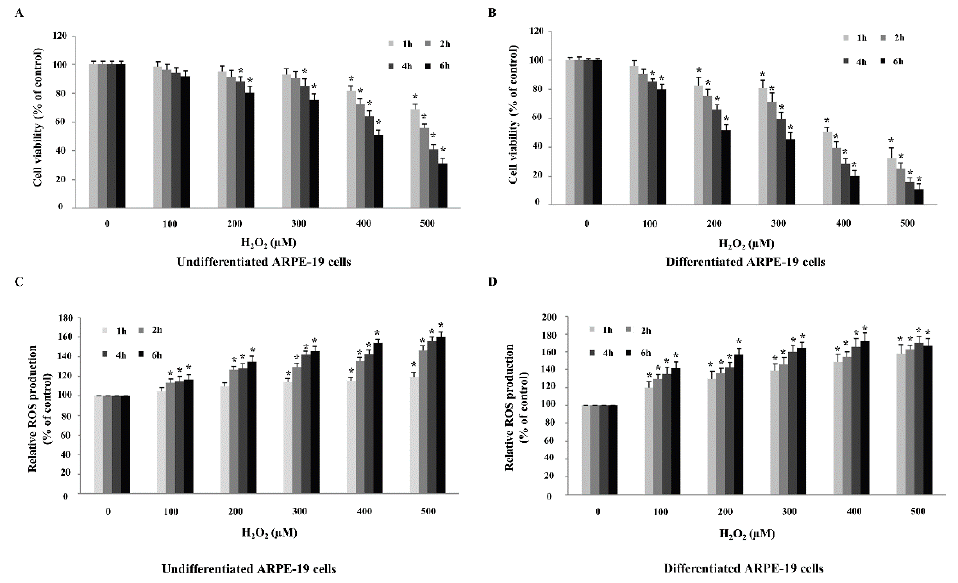
Figure 3. Evaluation of H 2 O 2 treatment and exposure time needed for reactive oxygen species (ROS) generation and oxidative stress-induced ARPE-19 cell death. ( A ) Undifferentiated and ( B ) differentiated ARPE-19 cells were treated with different concentrations of H 2 O 2 (within the range 100–500 µM) over a time course of 0–6 hours after which cell viability was measured using MTT assay. ROS production was also measured under the same experimental conditions for both (C) undifferentiated and (D) differentiated ARPE-19 cells. Graphs represent average cell viability and relative ROS production (mean ± SD values, n = 4; One-Way ANOVA test, * p ≤ 0.05 vs. control group).